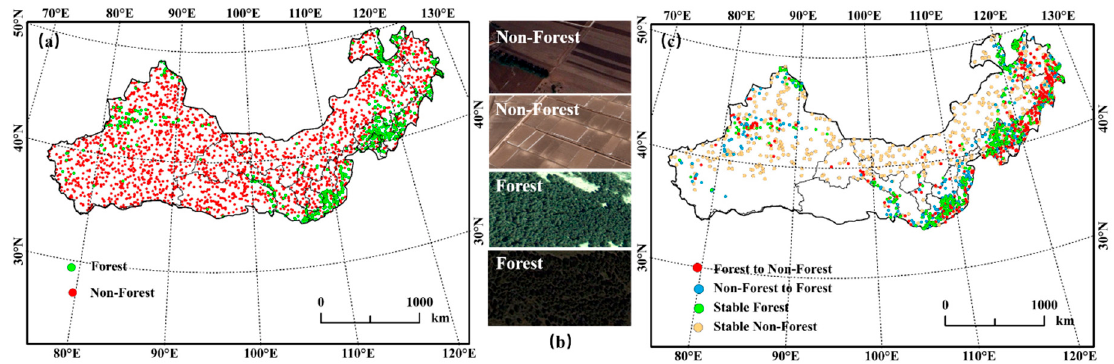
Figure 5. Spatial distribution of validation samples for accuracy assessment ( a ) 554 forests samples and 2234 non-forest samples in 2010. ( b ) Four examples of samples selected from Google Earth VHR images of 2010. ( c ) Four classes of samples to assess the forest changes from 2007 to 2017.